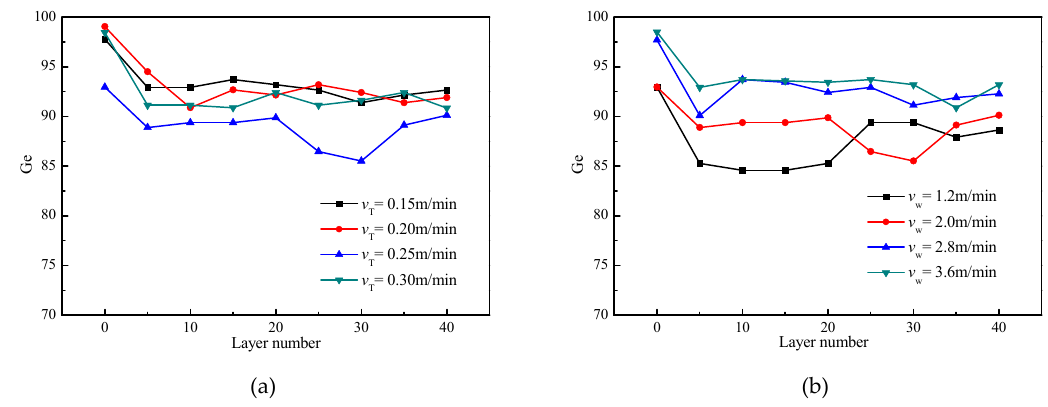
Figure 11. Ge number variation when deposited with different ( a ) travel speeds v T and ( b ) wire feed speeds v w .